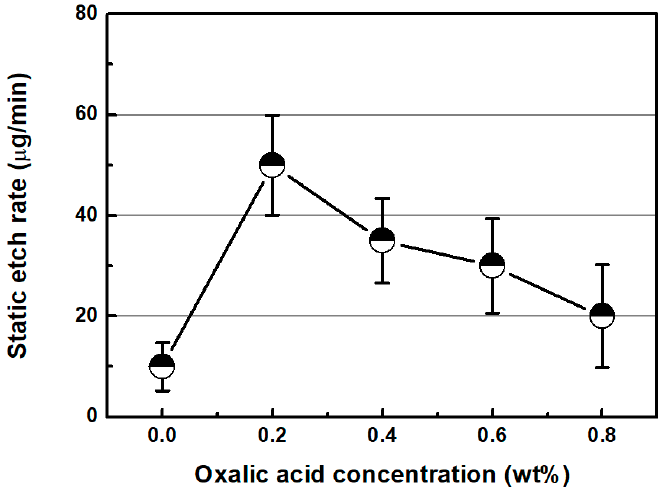
Figure 11. Static etch rate as a function of oxalic acid concentration (H 2 O 2 concentration: 0.33 wt %).